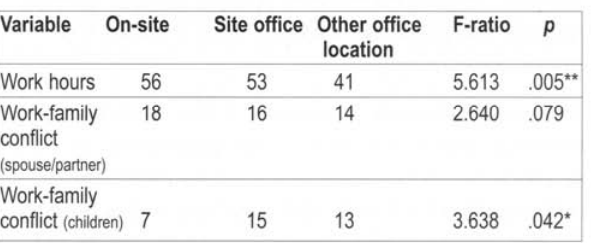
Table 2: Mean comparisons of work-family experiences by work location These results show some significant